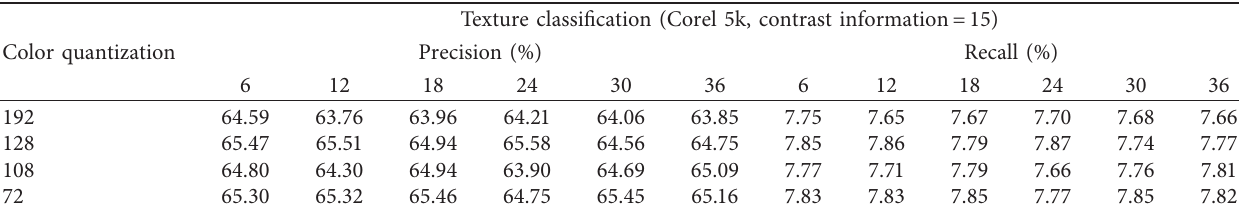
Table 3: Average retrieval precision and average retrieval recall of NRLGO at varying values of gradient orientation and color quantization levels by keeping local contrast information fixed at 15 on Corel 5k in HSV. Color quantization